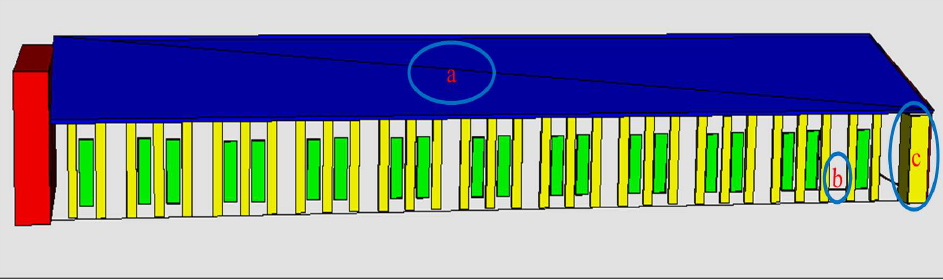
Figure 4: Comparison of manual processed model and grammar-based automatic reconstructed models with different rule sets for a single-floor building. Colours in reconstructed models stand for roof in blue, window in green, wall column in yellow, and base wall in